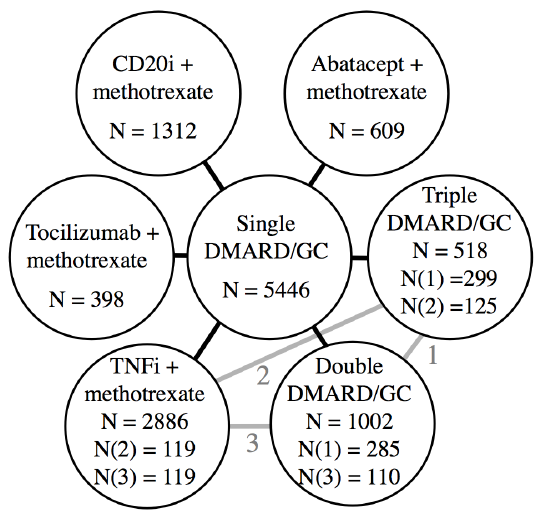
Figure 3. Star shaped network showing the 6 different combination treatments anchored on single treatment as the common comparator. The loops (grey lines) with corresponding numbers (1, 2, 3) show the subgroups, which were directly compared in addition to being indirectly compared. N indicates the number of patients in the